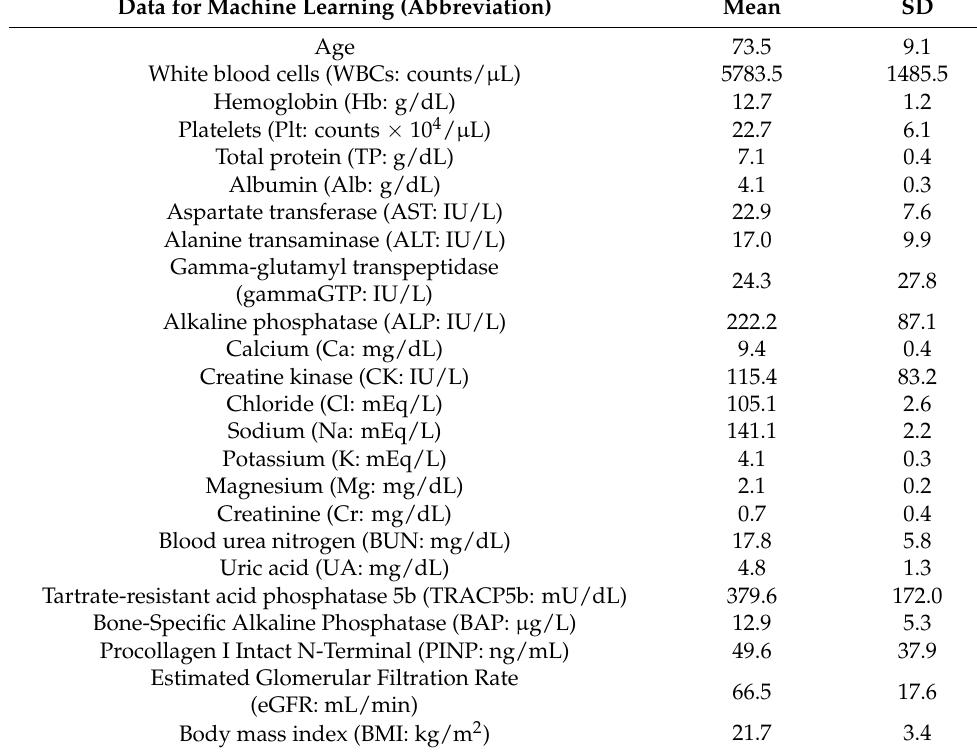
Table 1. Mean ± SD of patient age, blood test data, and